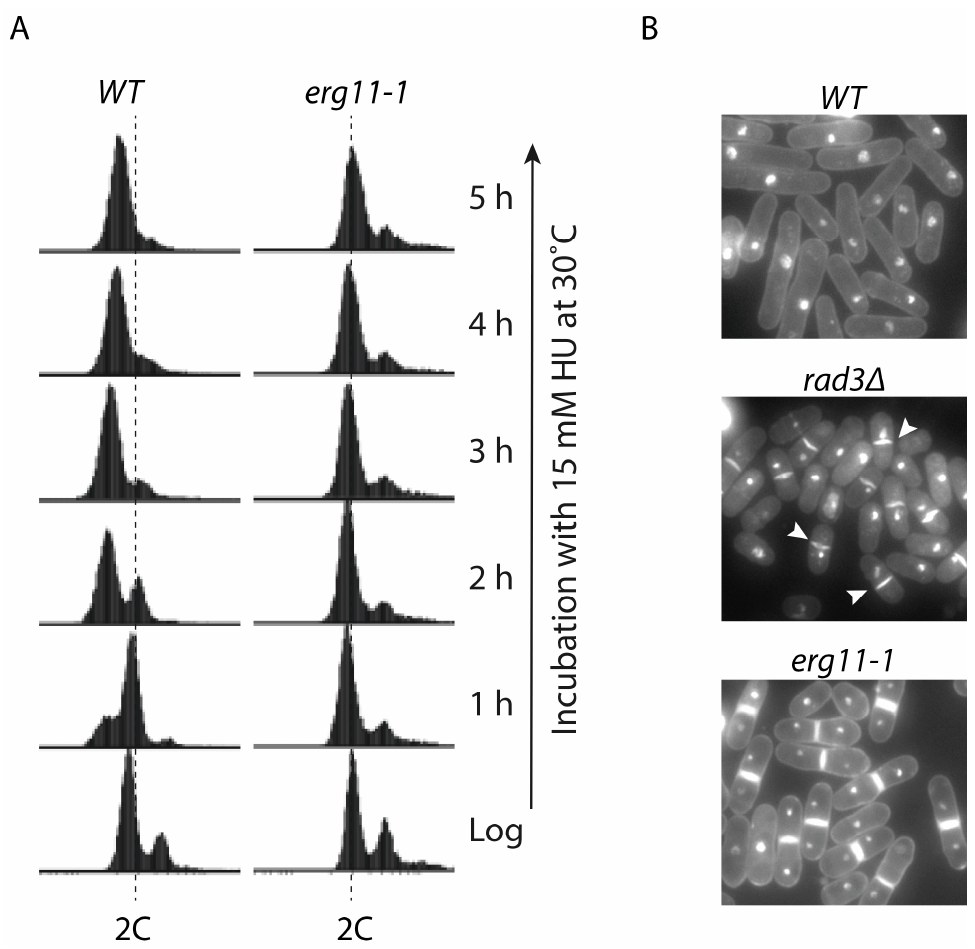
Figure 2. HU induces cytokinesis arrest in Schizosaccharomyces pombe erg11-1 mutant. ( A ) unlike wild type (WT) cells that are arrested in S phase, HU arrests erg11-1 cells in G2/M phase. Cell cycle progression of the wild type and erg11-1 mutant cells cultured in YE6S medium containing 15 mM HU was monitored during the course of incubation at the indicated time points by flow cytometry. Dashed lines indicate the cells with a 2C DNA content. Since most of the S. pombe cell cycle time is at G2 phase, the majority of the logarithmically growing cells (Log) have a 2C DNA content; ( B ) wild type S. pombe , the checkpoint mutant rad3 ∆ lacking the sensor protein kinase Rad3 (ortholog of human ATR and Saccharomyces cerevisiae Mec1), and erg11-1 cells were treated with 15 mM HU for 3 h at 30 ◦ C in YE6S medium and then stained with propidium iodide (PI) for genomic DNA and Blankophor for cell wall and the septum. The stained cells were examined under a fluorescent microscope. Arrowheads indicate cells with the “cell untimely torn” or cut phenotype in rad3 ∆ cells, a strong indicator of aberrant mitosis in HU-treated checkpoint deficient mutants [77]. (This figure is adapted from the reference [21] with permission from The Genetics Society of America).